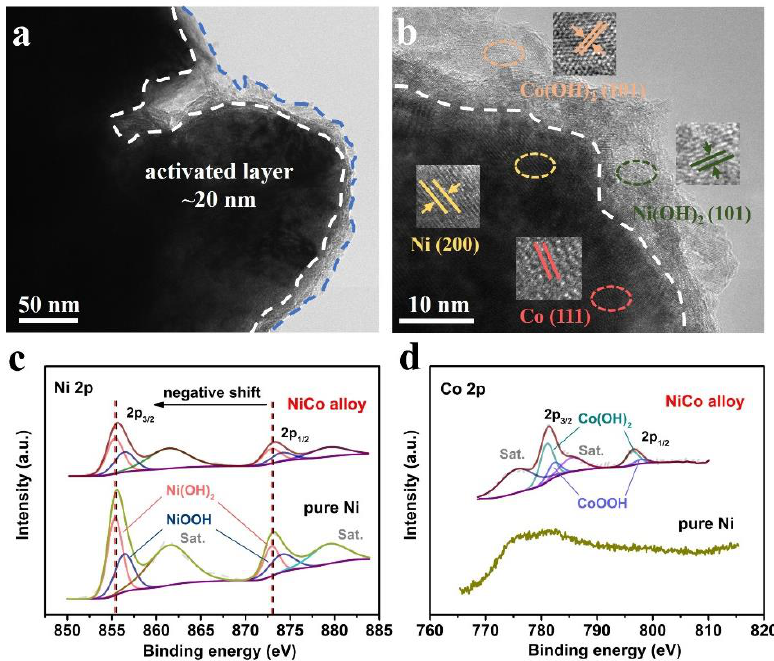
Figure 2. ( a ) TEM image and ( b ) HRTEM image of reconstructed NiCo alloy, and XPS ( c ) Ni 2p and ( d ) Co 2p signals for both pure Ni and NiCo alloys after reconstruction.